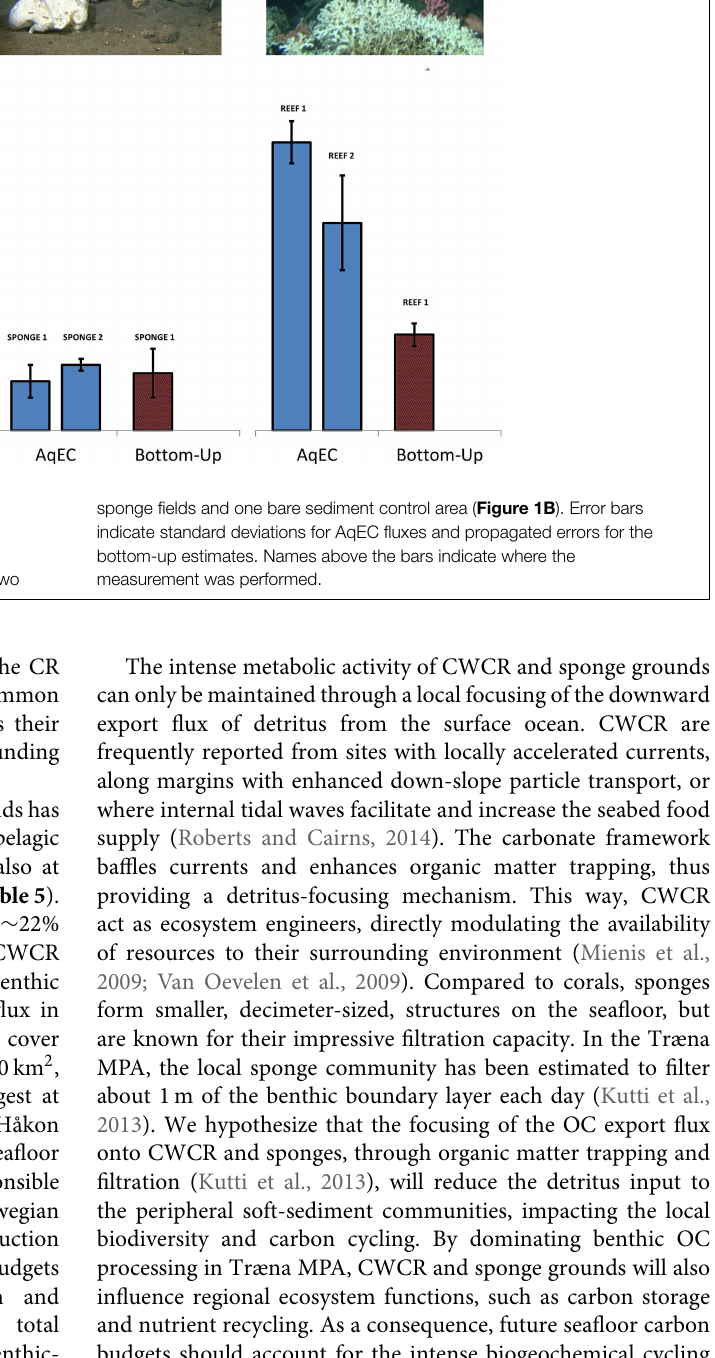
FIGURE 3 | Community respiration rates in bare sediment (left), sponge ground (center), and cold-water coral reef (right). AqEC, Aquatic Eddy Correlation. Bottom-up, Bottom-up community respiration rate. AqEC fluxes correspond to separate deployments over two reefs, two